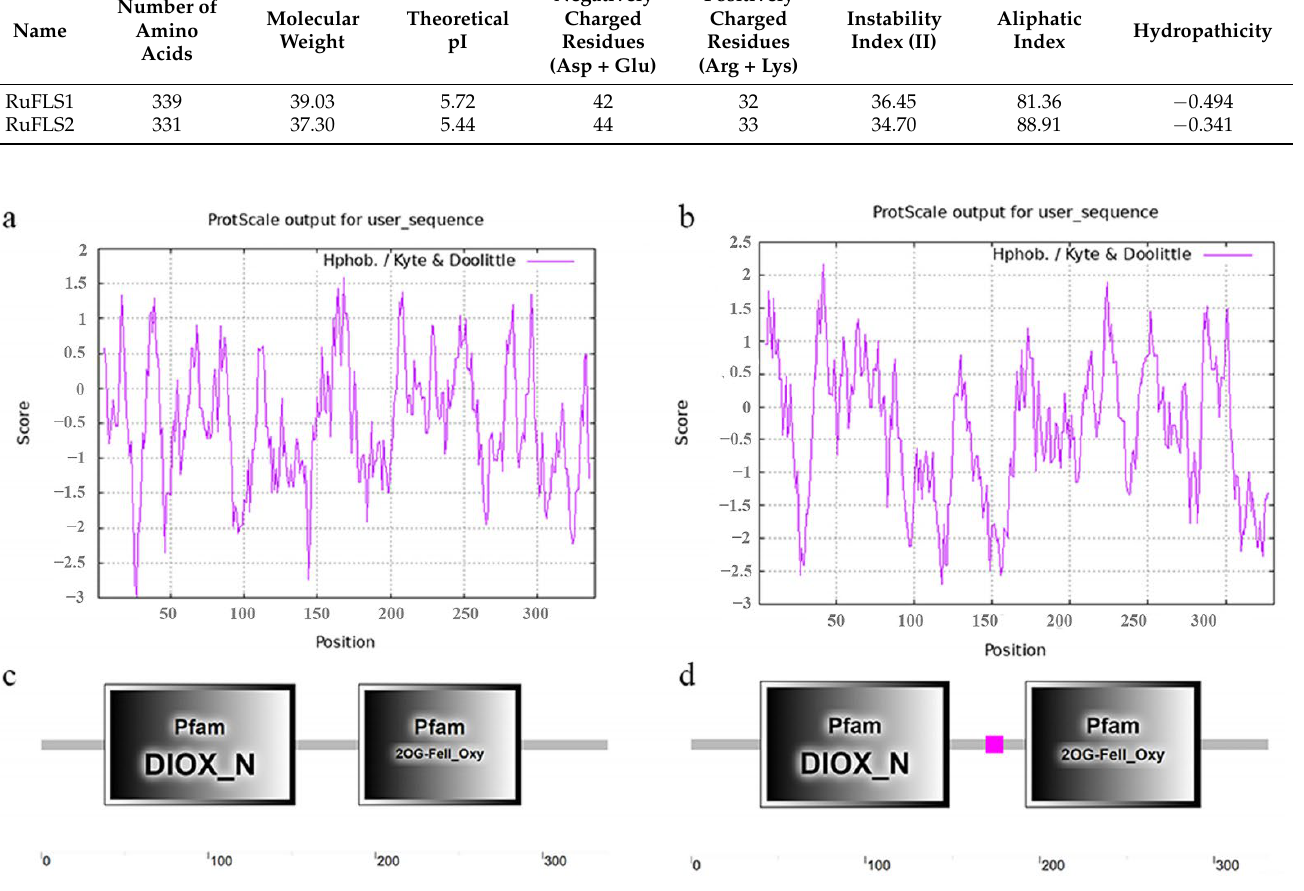
Figure 1. Prediction of the hydrophilicity and structural domains of RuFLS proteins. ( a ) Hydrophilicity of RuFLS1; ( b ) Hydrophilicity of RuFLS2; ( c ) Structural domains of RuFLS1; and ( d ) Structural domains of RuFLS2.